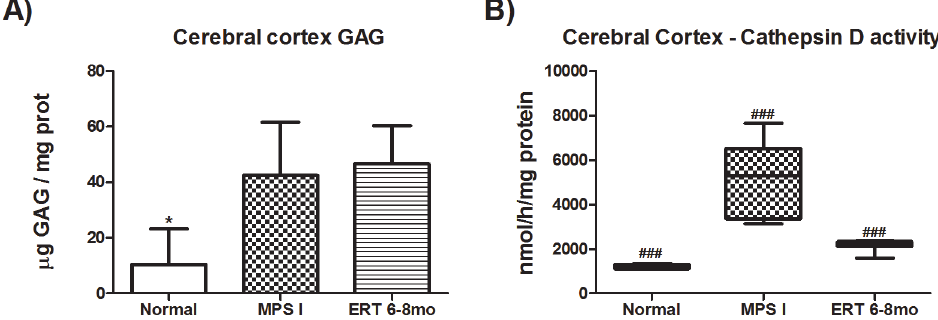
Fig 5. Brain disease markers. A) Cerebral cortex GAG levels and B) Cathepsin D activity in 8-month old normal (n = 5), MPS I (n = 5) and 6 to 8 months laronidase treated MPS I (ERT 6 – 8mo, n = 10), 2 weeks after last injection. * P = 0.02, ANOVA and Tukey. ###P < 0.001, Kruskal-Wallis and Mann-Whitney post hoc